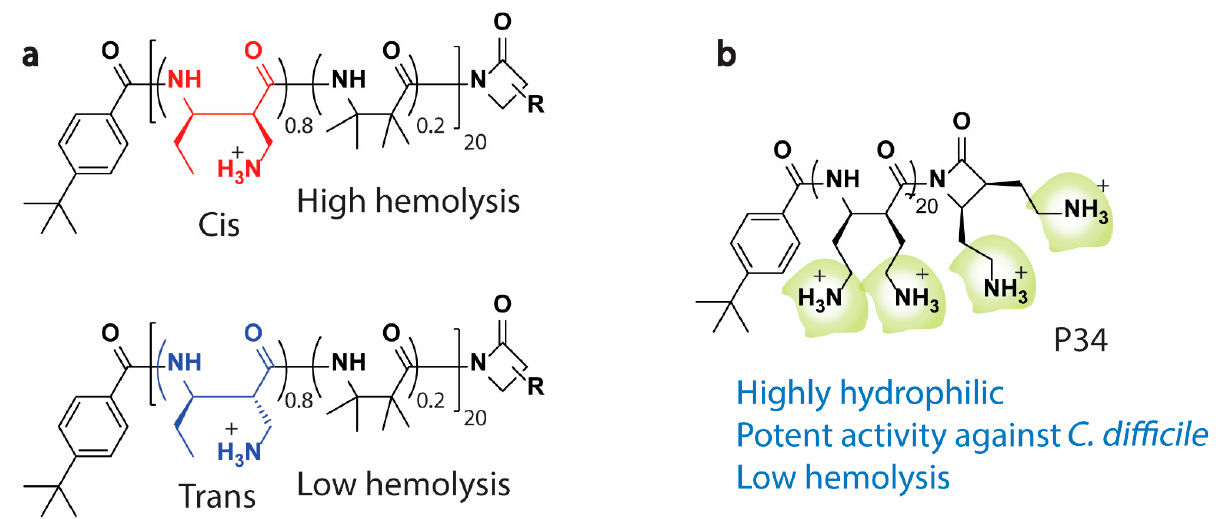
Figure 4. Beyond the amphiphilic balance of antimicrobial polymers. ( a ) Stereochemistry alters the activity of nylon-3 copolymer [89] and ( b ) an example of homopolymers with only cationic subunits (P34) but potent antibacterial activity and low toxicity against RBCs [90].